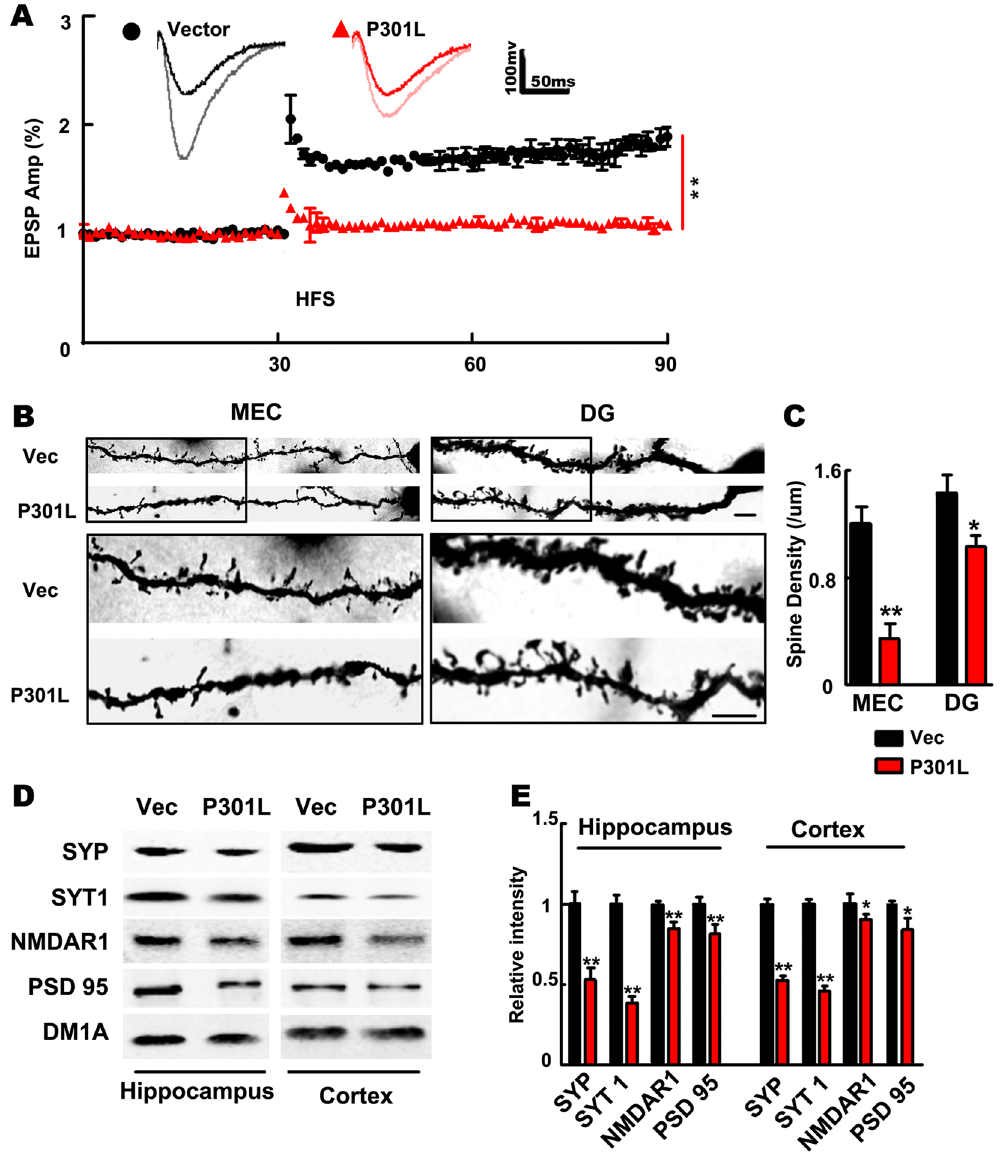
Figure 6. Expression of P301L hTau in MEC inhibits synaptic plasticity of PP-DG. ( A ) The Long-term potentiation of PP-DG was inhibited in P301L hTau transduced mice. The inset graphs represent for each group an example of unit fEPSP before (dark line) and after (light line) LTP induction, which revealed that LTP induction is reduced in P301L hTau transduced mice (HFS, high frequency stimulation. n = 3 per group, 9 slices ** p < 0.01). ( B ) Golgi-stain revealed that the MEC spine density was decreased in MEC and DG of P301L hTau transduced mice. ( C ) Quantitative analysis of spine density. (n = 3 per group, 9 slices, ** p < 0.01. Scale bar, 10 μ m). ( D , E ) Levels of synaptophysin and synaptotagmin I (presynaptic proteins) and NMDAR1 and PSD95 (postsynaptic proteins) were decreased in both the hippocampus and cortex of P301L hTau transduced mice (n = 3 per group, * p < 0.05). Cropped blots are displayed here and full-length blots are included in the Supplementary Information. Data were expressed as mean ±